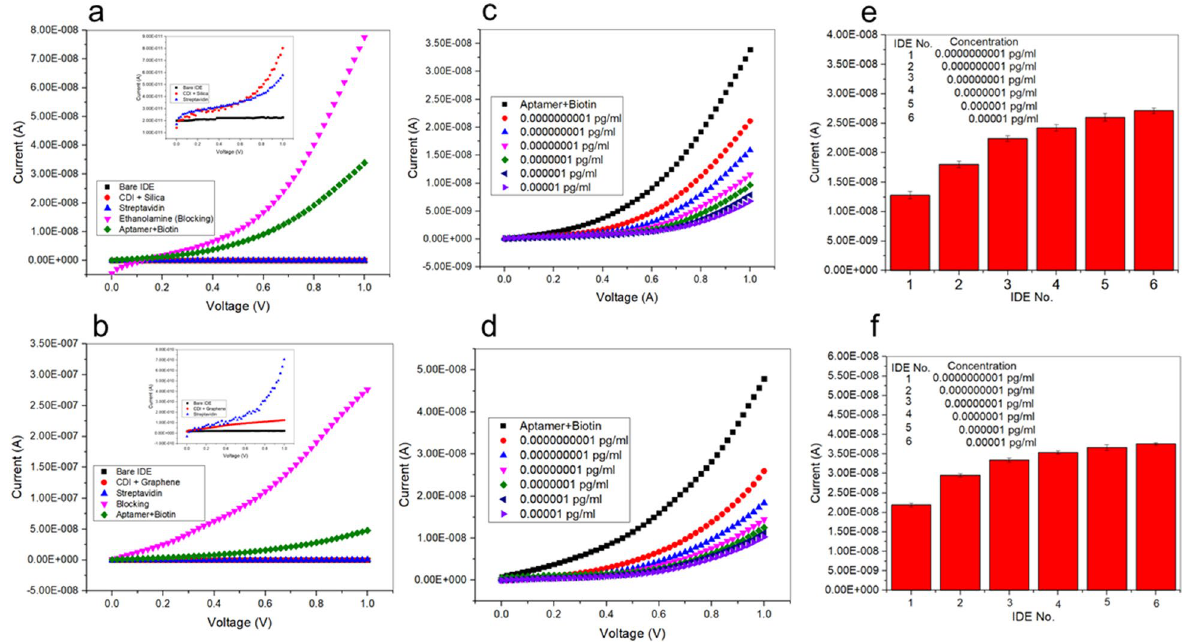
Figure 5. Surface functionalization measured by voltammetry signal. The inset graph represents the current values recorded with bare, CDI-silica or CDI-graphene, and streptavidin Al IDEs modified with ( a ) silica nanoparticles and ( b ) graphene. The figure insets represent enlarged portions of bare IDE, CDI-Silica or CDI- Graphene and Streptavidin. We evaluated the impact of the interaction between ( c ) CDI-silica nanoparticles or ( d ) CDI-graphene. The current measurements for different concentrations of arsenic detected with ( e ) CDI- silica and ( f ) CDI-graphene Al IDEs are presented